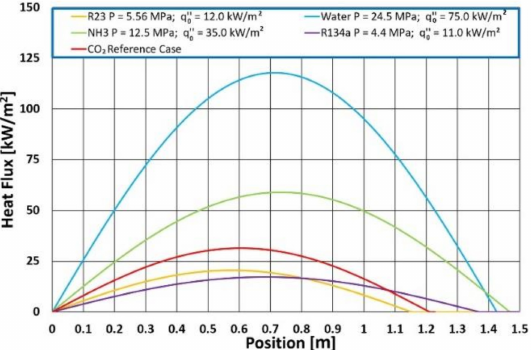
Figure 17. Heat flux distributions for the best-matching operating conditions for the reference CO 2 case considering q 0 (cid:48)(cid:48) = 20 kW/m 2 and T in = 24 ◦ C.